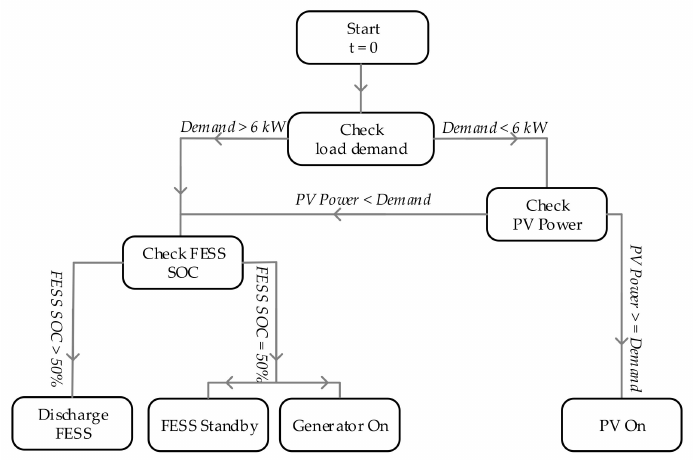
Figure 18. Power transfer flow chart of FESS, PV, and